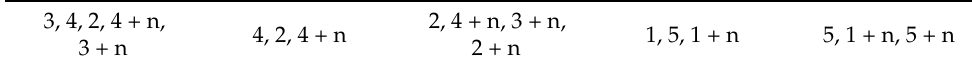
Swaps a pickup and delivery with another pickup and delivery node within the Half of the time, performs a request swap and half of the time, performs an end request stop.